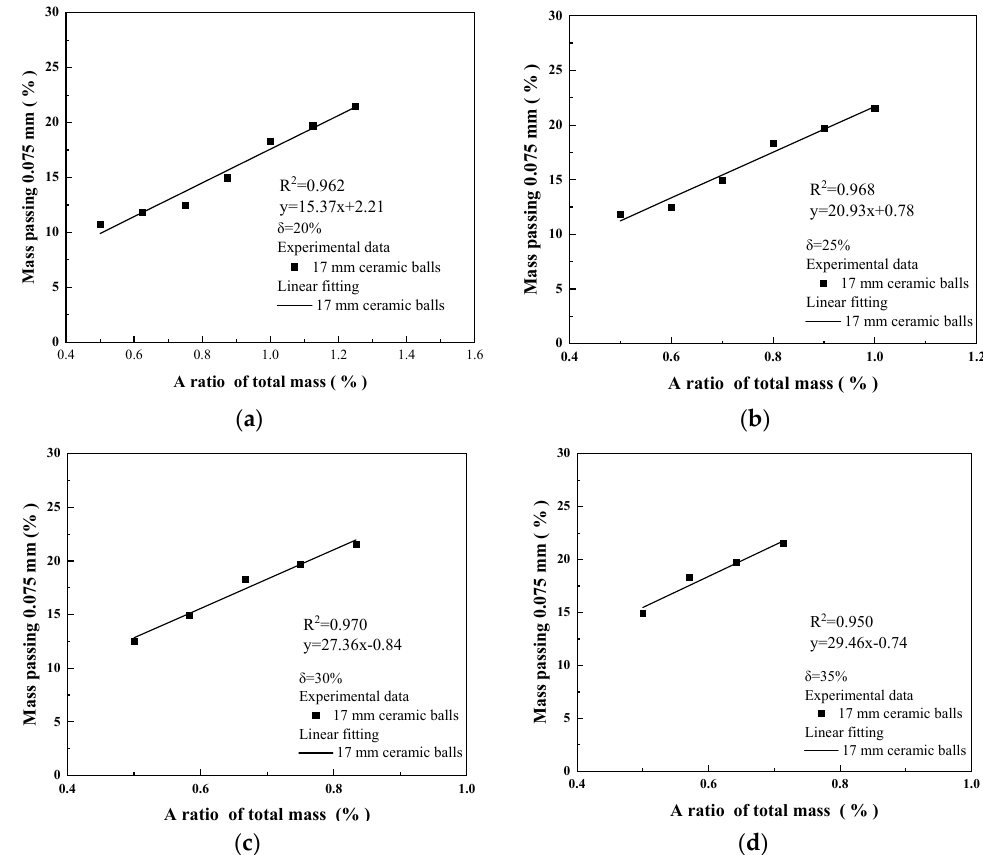
Figure 11. The relationship of the distribution of the percentage passing 0.075 mm in the ground product and the ratio of the total mass of 12 × 12 mm cylpebs in a wider charge volume: ( a ) J = 20%; ( b ) J = 25%; ( c ) J = 30%; ( d ) J = 35%.